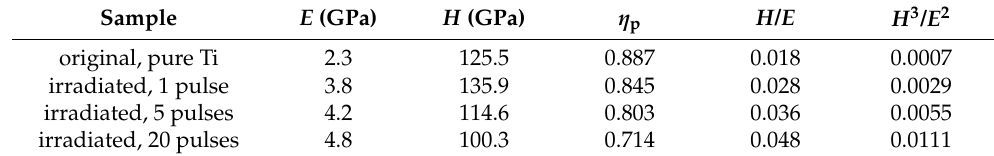
Table 1. Nanoindentation results of pure Ti and Ti-Cr alloy coating samples with different pulses of